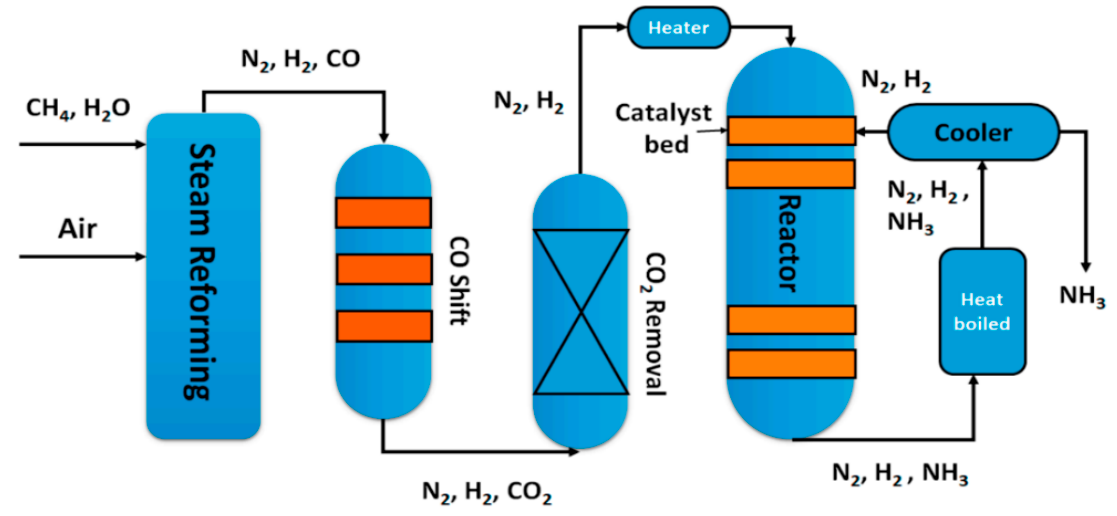
Figure 1. A flow scheme of the Haber–Bosch process, reproduced from [3], with permission from MDPI, 2018.